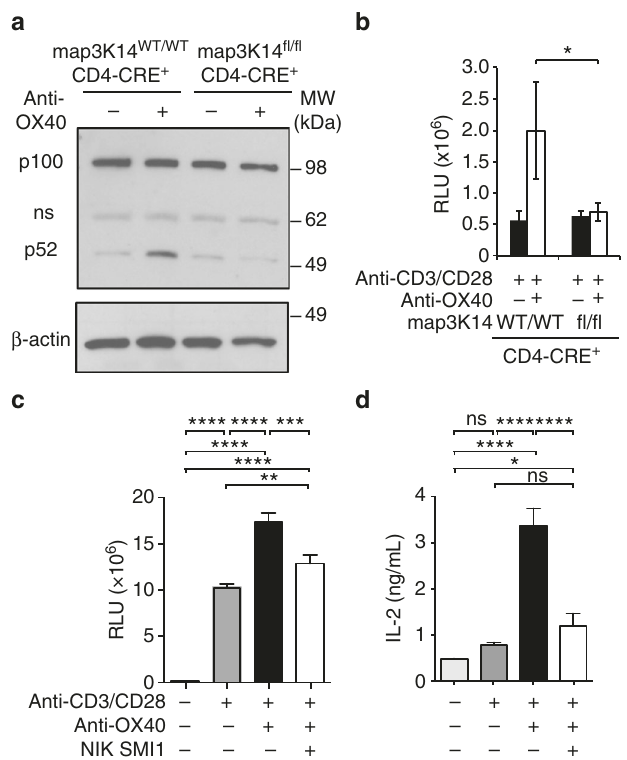
Fig. 3 NIK is required for OX40-induced T cell co-stimulation. a Western blot of anti-OX40 agonist antibody induced p52 processing in anti-CD3/ anti-CD28 stimulated CD4 + T-cells isolated from Map3k14 WT/WT , CD4- CRE + or Map3k14 fl / fl , CD4-CRE + mice. b anti-OX40 induced hyper- proliferation of CD4 + T-cells isolated from Map3k14 WT/WT , CD4-CRE + or Map3k14 fl / fl , CD4-CRE + mice as assessed by Cell Titer Glo ( n = 2). c anti- OX40 induced hyper-proliferation of memory CD4 + T-cells in the absence or presence of 3 μ M NIK SMI1 as assessed by Cell Titer Glo ( n = 2). d Effect of NIK SMI1 on anti-OX40 augmented IL-2 production in c . Data are represented as mean ± standard deviation of three biological